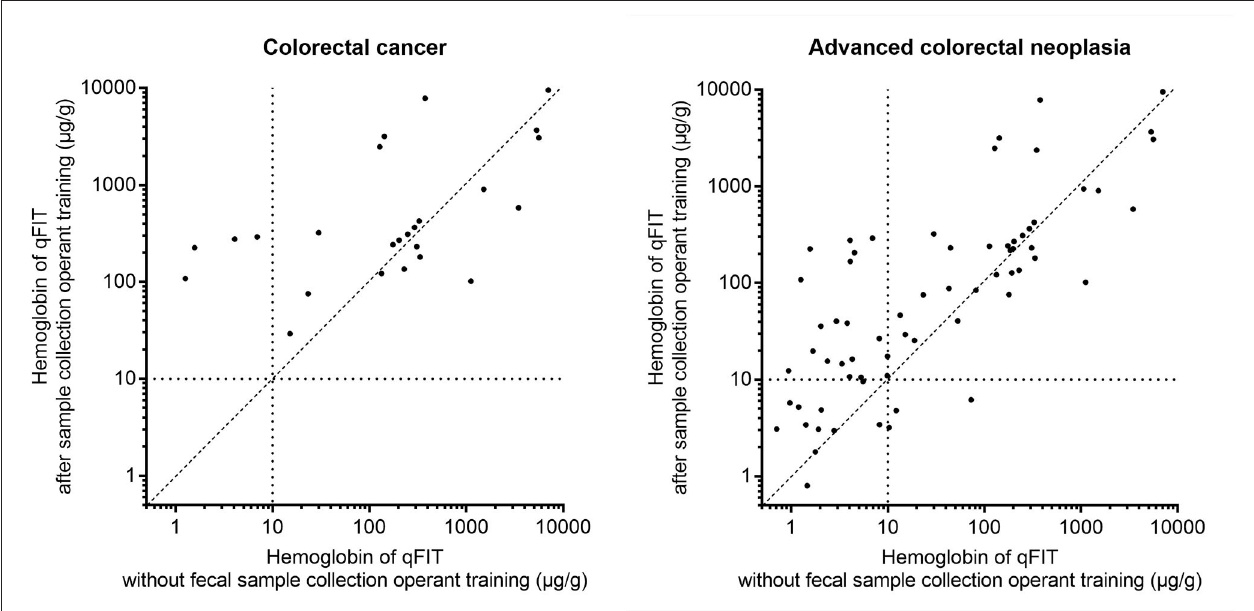
FIGURE 3 | The distribution of the concentration of the hemoglobin (Hb) for the qFIT without and after the practical sample collection operant training for CRC and advanced colorectal neoplasia (ACRN). Each point represents the measurements of the Hb of the qFIT for one patient. The horizontal and vertical dotted lines show the limit of quantitation of the instrument. The oblique line divides the points into two parts. Points above/under the oblique line show the individuals whose detection value of the qFIT after the practical operant training was higher/lower than that without the operant training. Points in the upper left quadrant indicate the concentration of the fecal Hb that was detected by the qFIT after the operant training but not detected by the qFIT without the operant training. Points in the right lower quadrant indicate the concentration of the fecal Hb that was not detected by the qFIT after the operant training but detected by the qFIT without the operant